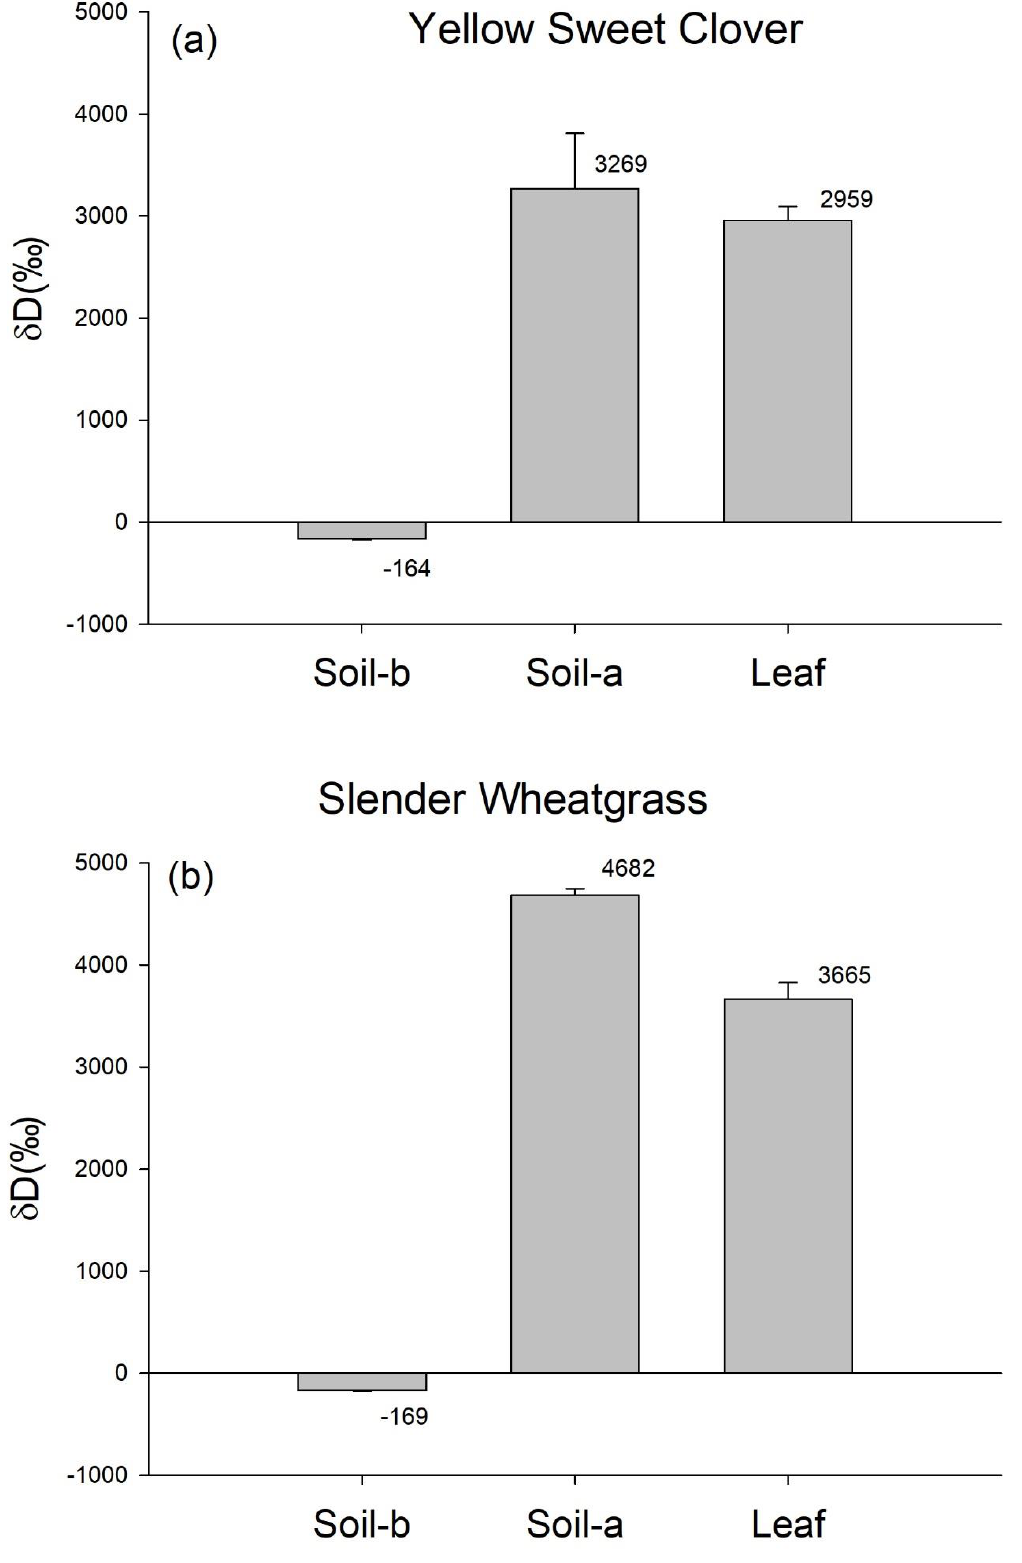
Figure 4. Hydrogen isotope ratios (δD) of extracted water from the soil in the upper tube (soil-a), lower tube (soil-b), and leaves of the yellow sweet clover ( a ) and slender wheatgrass ( b ) in Study 1, when deuterium-enriched water was supplied only to soil in the upper tube. The δD of the control water was −220‰. Means ± SE ( n = 3) are shown.